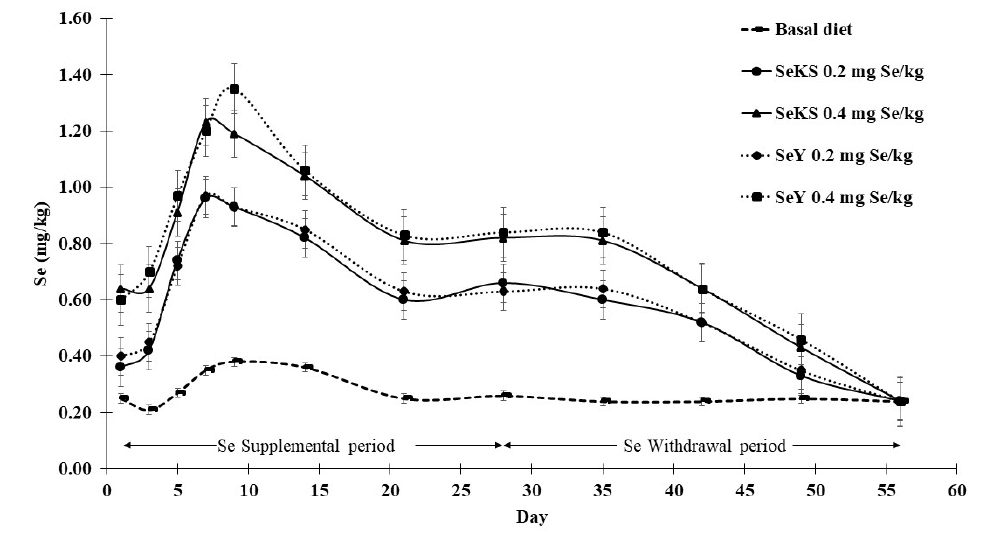
(cid:31)(cid:30)(cid:30)(cid:29)